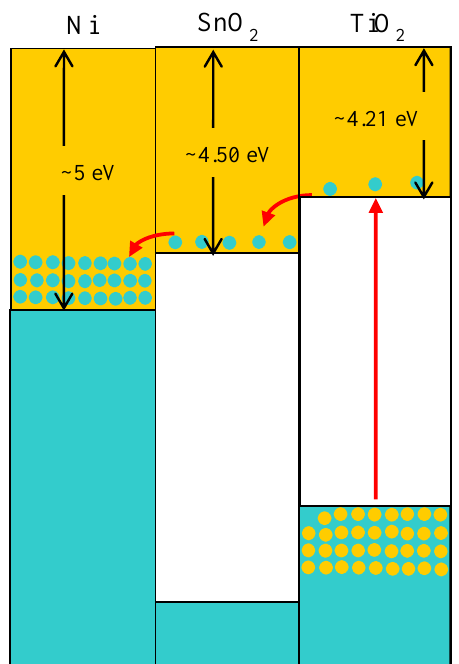
Figure 8. Schematic energy band diagrams of TiO 2 /SnO 2 /Ni multi-junctions showing the mechanism of efficient carrier separation.